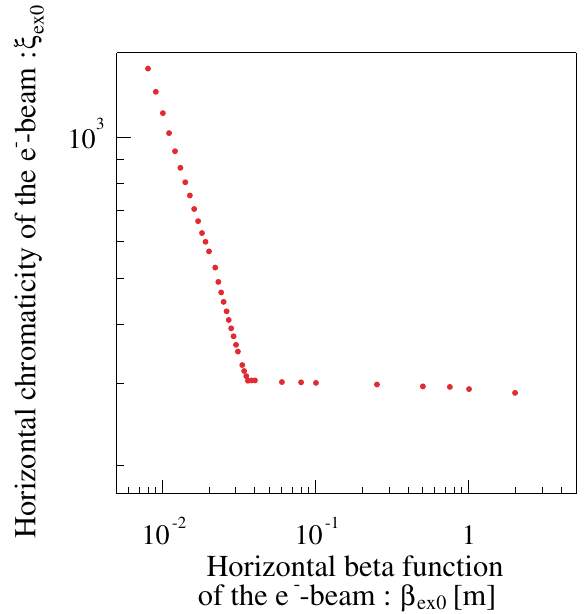
FIG. 6. (Color) Horizontal chromaticity of the e (cid:1) beam as a function of the horizontal beta function calculated using SAD